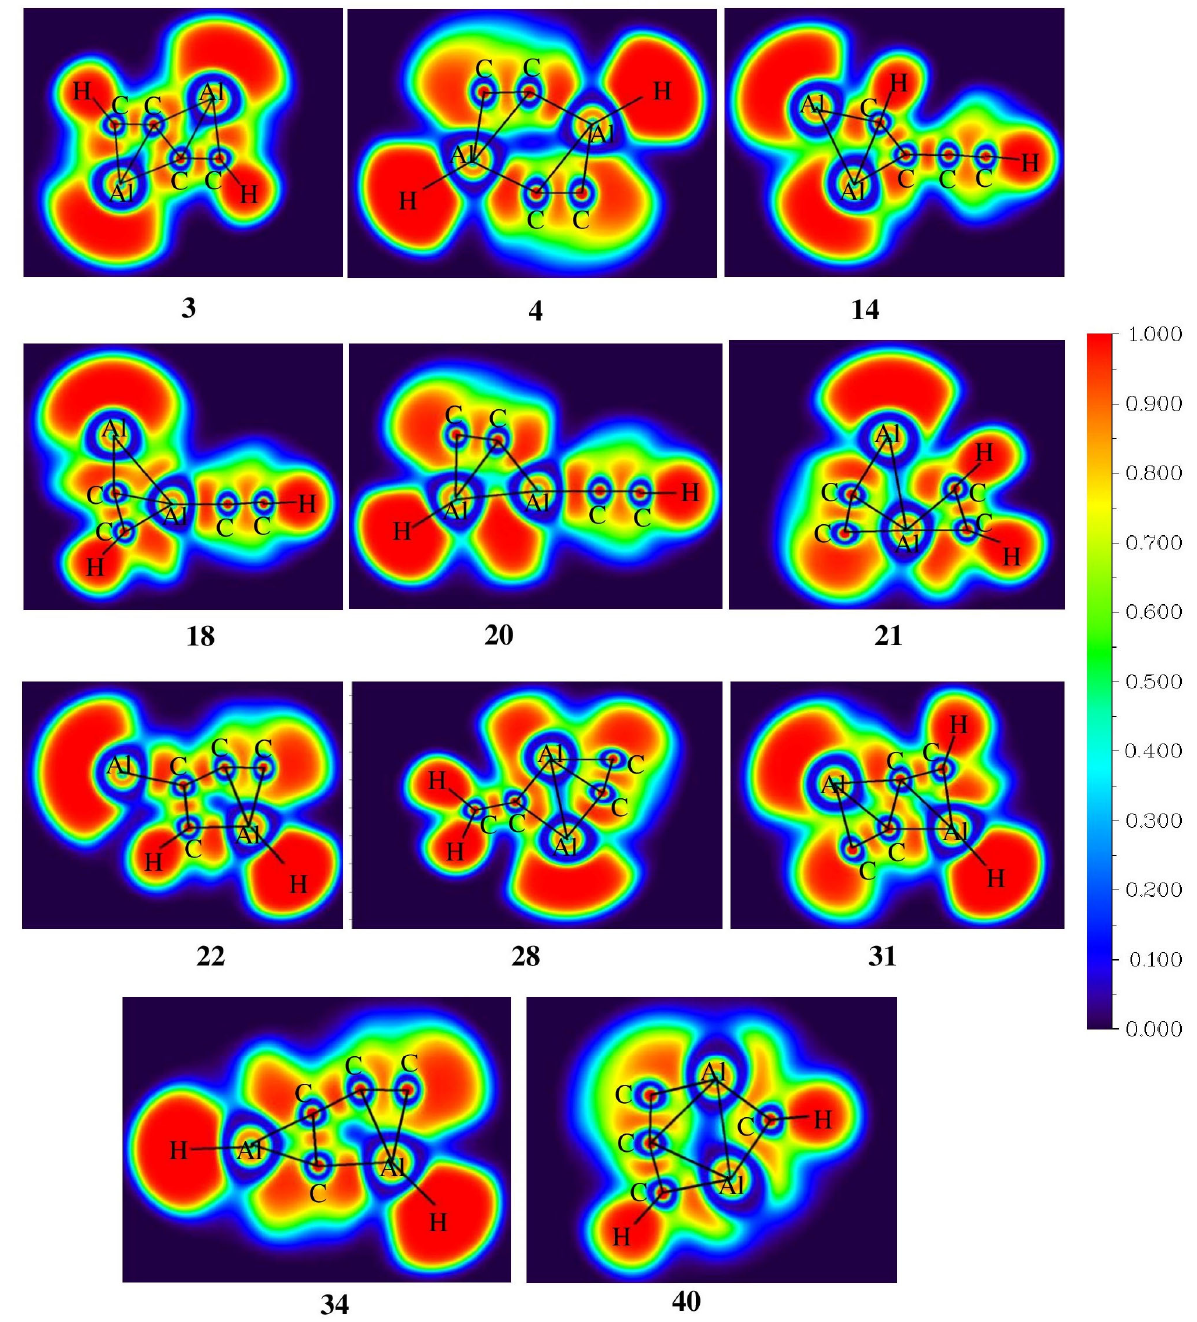
Figure 4. Color ‐ filled map of ELF for isomers 3 , 4 , 14 , 18 , 20 , 21 , 22 , 28 , 31 , 34 , and 40 obtained at the ω B97XD/6 ‐ 311++G(2d,2p) level of theory.